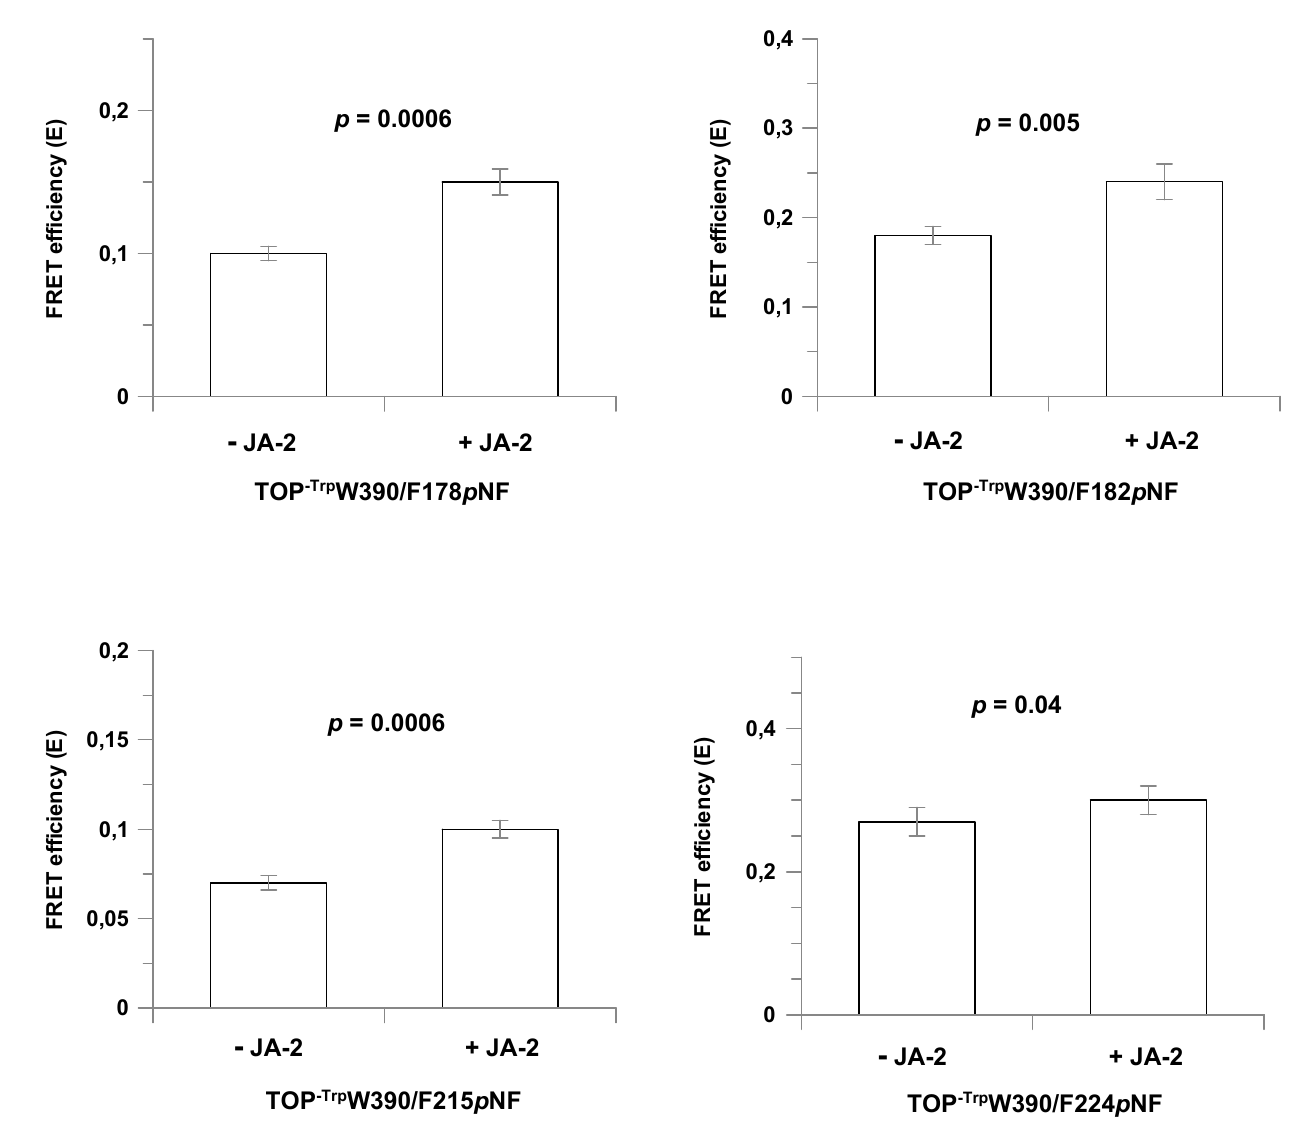
Figure 3. FRET efficiencies (E) obtained for the double labeled Trp- p NF TOP mutants in the absence or in the presence of JA-2. The p- values ( p ) were estimated by using the student’s t test. FRET efficiencies were determined at 37 ◦ C in 50 mM Tris-HCl buffer, pH 7.4, containing 100 mM NaCl and 0.5 mM of DTT.